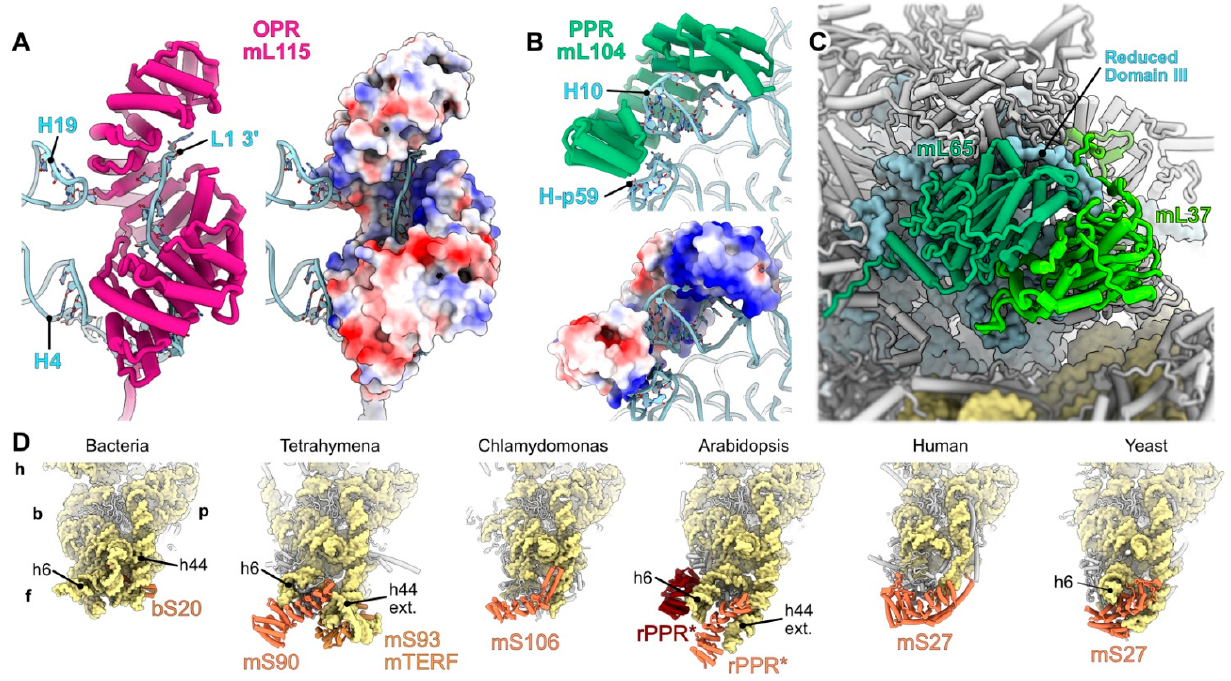
Figure 3. Examples of RNA-binding proteins recruited to mitoribosomes. ( A , B ) present close-up views of large alpha-helical proteins which were largely recruited to mitoribosomes. ( A ) The OPR mL115 involved in the stabilization of fragment L1 of the fragmented rRNAs of C. reinhardtii is shown. The OPR enlaces the 3’ single-stranded extremity of the L1 fragment which is stabilized via charge interaction. It also interacts with H19 and H4. The electrostatic potential of mL115 is shown with blue surfaces showing positive charges and red surfaces showing negative charges. ( B ) The PPR mL104 of the flowering plant mitoribosome is shown. It englobes helix H10, interacting with the rRNA backbone which is a different mode of action compared to non-ribosomal PPR proteins. It also interacts with H-p59, a plant specific RNA helix. As in ( A ), the electrostatic potential of mL115 is shown, revealing that the rRNA interaction is mostly mediated by positively charged residues. ( C ) The pseudo-dimer composed of mL65 and mL37, probably repurposed endonucleases, are shown as an example of non-alpha-helical mitoribosome-specific r-proteins. The r-proteins interact with the reduced domain III of the large subunit of the mammalian mitoribosome. ( D ) Structural comparison of the foot of the small subunit. This comparison highlights the conserved helical proteins involved in the stabilization of the foot of the small subunit—where the tip of h44 and h6 are either extended, reduced, or deleted—most likely due to the loss of the bacterial r-protein bS20 in mitoribosomes. All mitoribosomes share a PPR protein at this position (mS27, mS90, rPPR* and mS106), which may be the product of a single ancestral PPR protein. In trypanosoma, PPR protein mS63 is also present at this position but no longer interacts via RNA. The different parts of the small subunit are indicated on the bacterial model; h: head, b: body, f: foot, p: platform.